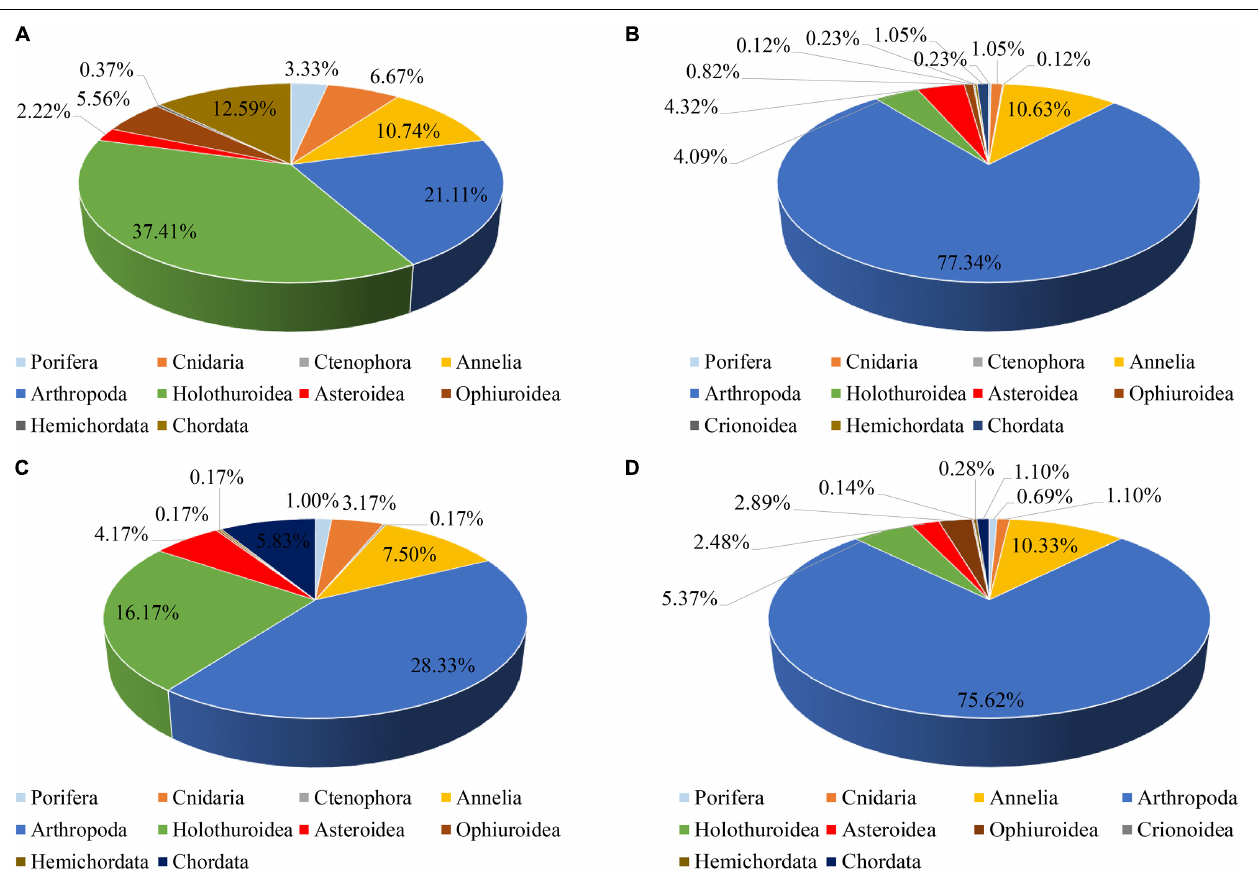
FIGURE 4 | Comparison of megafauna structure among (A) the abyssal zone; (B) the hadal zone; (C) the north section; (D) the south section in the Yap Trench.